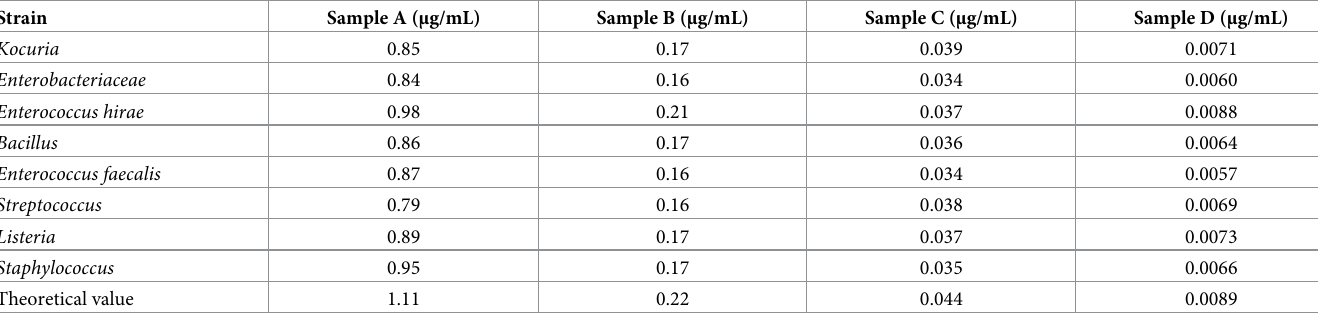
Table 3. The absolute amount quantification of the gene using an internal